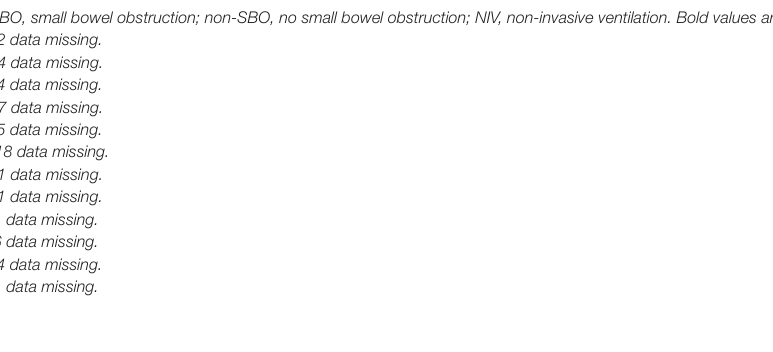
TABLE 4 | Differences in postoperative treatment and concerning re-operations between SBO- and non-SBO-patients. Duration of invasive ventilation in